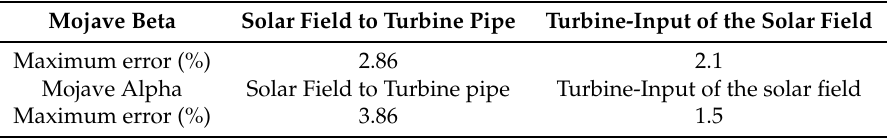
Table 3. Maximum error between the model output and the real